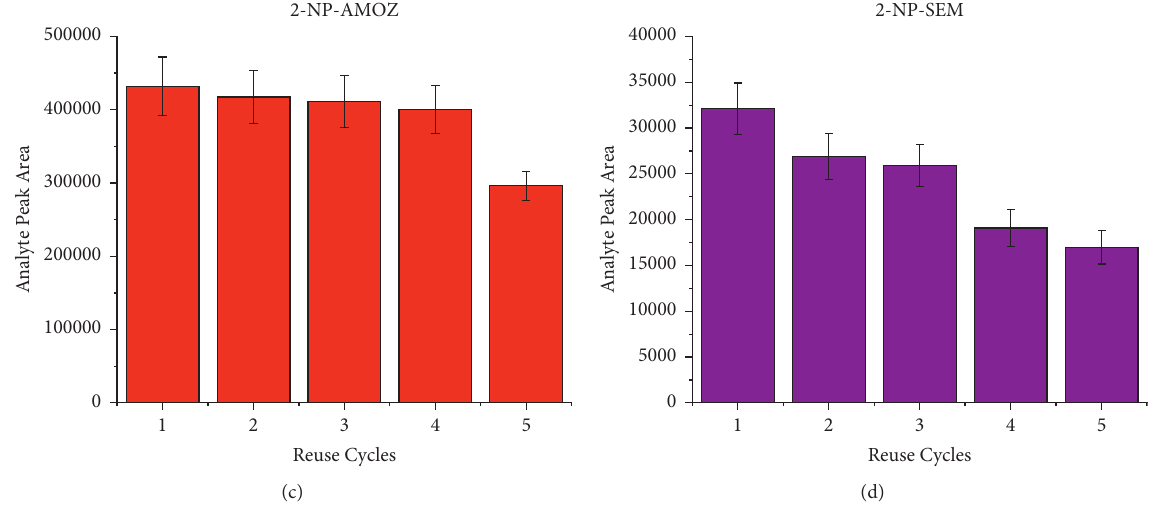
Figure 5: Regeneration of the SPME for five reuse cycles.